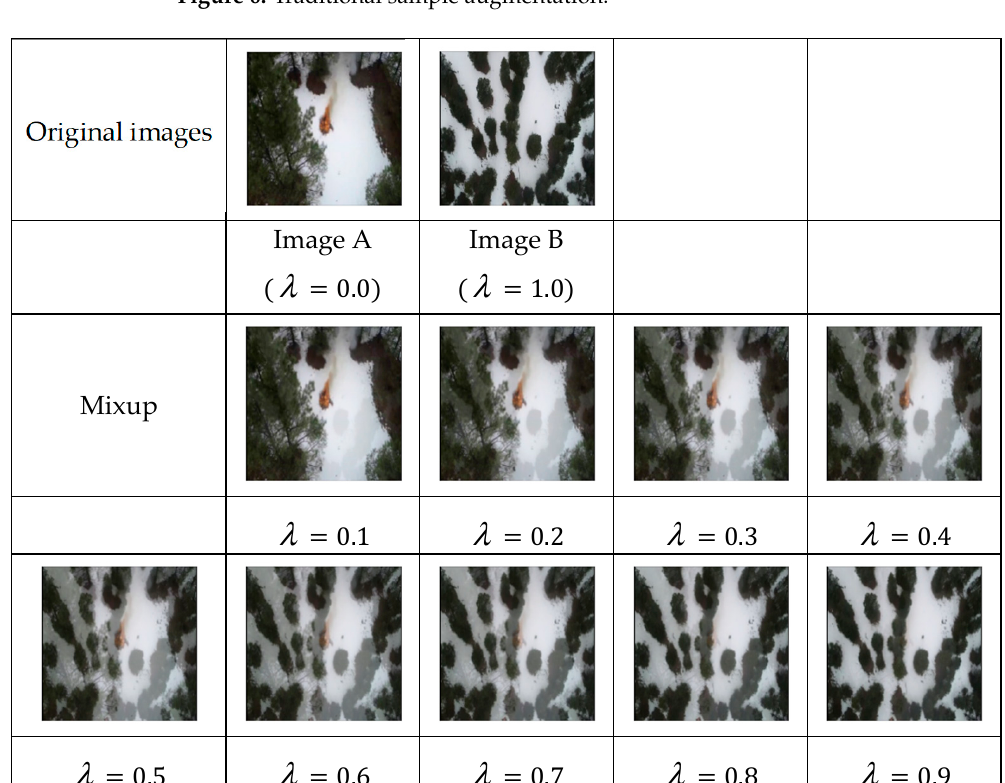
Figure 7. Mixup-based sample augmentation.